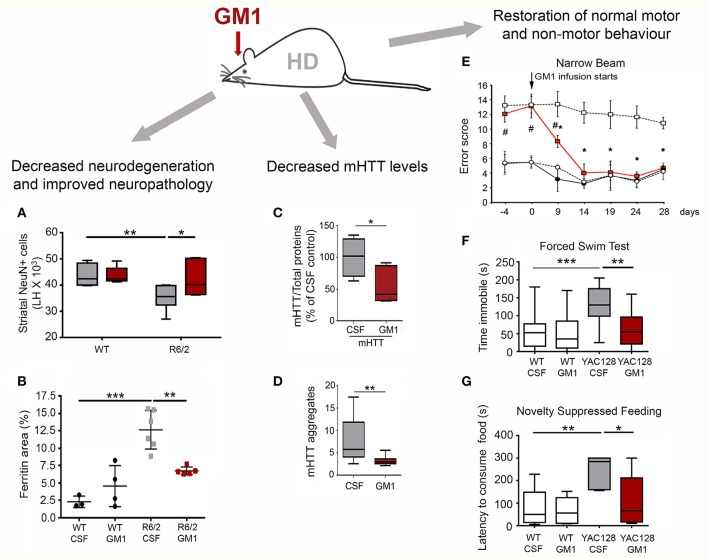
Disease-modifying effects of GM1 administration in HD mouse models. (A) Intraventricular infusion of GM1for 28 days resulted in a significant decrease in striatal neuron loss in the R6/2 mouse model of HD. LH, Left brain hemisphere. (B) Brain ferritin accumulation was attenuated in R6/2 mice treated with GM1. (C) Mutant HTT protein levels were decreased in the striatum of Q140 mice treated with GM1 for 42 days. (D) GM1 administration also attenuated accumulation of SDS-insoluble mHTT aggregates (as measured by a filter-trap assay). (E) GM1 administration resulted in restoration of normal motor function in YAC128 mice. Motor performance was scored as the mice walked along a narrow beam. (F) GM1 administration decreased depression-like behavior in YAC128 mice, as measured by the time mice spent immobile in a forced swim test. (G) In the novelty-suppressed feeding test, GM1 corrected anxiety-like behavior in YAC128 mice, as measured by the latency to consume sweetened condensed milk in a novel environment. Box-and-whisker plots show median, maximum and minimum values. *p < 0.05; **p < 0.001; ***p < 0.0001. (A–D,F,G) are reproduced with permission from Alpaugh et al. (120); (E) is reproduced with permission from Di Pardo et al. (119).